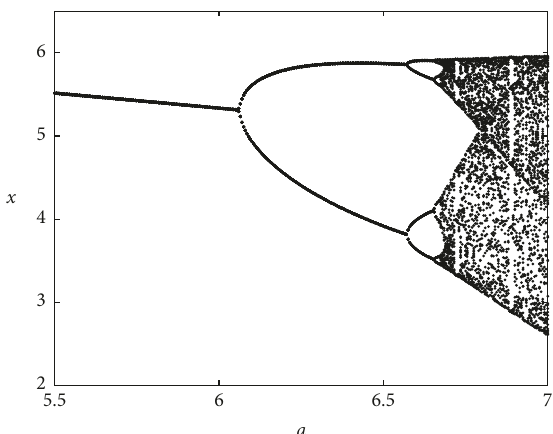
Figure 1: Presentation of the bifurcation diagram for 𝑎 ∈ [5.5, 7] , while 𝑏 = 4 and 𝑐 = 1 .